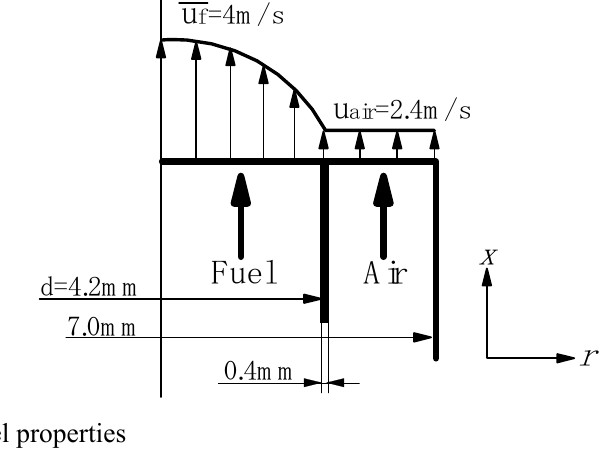
Figure 59. Schematic diagram of the axisymmetric laminar flame model and fuel